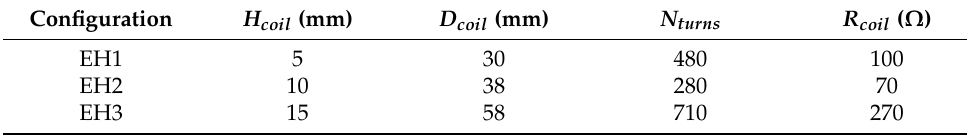
Table 3. Main characteristics of the